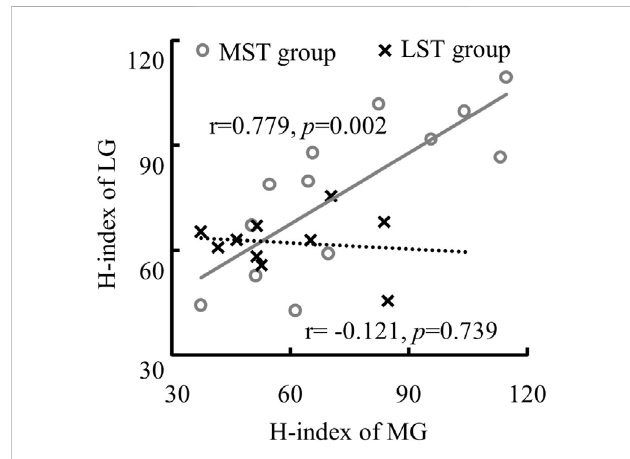
FIGURE 4 The linear relationship between the H-index of MG and LG with only signi fi cant correlation was detected in the MST group.